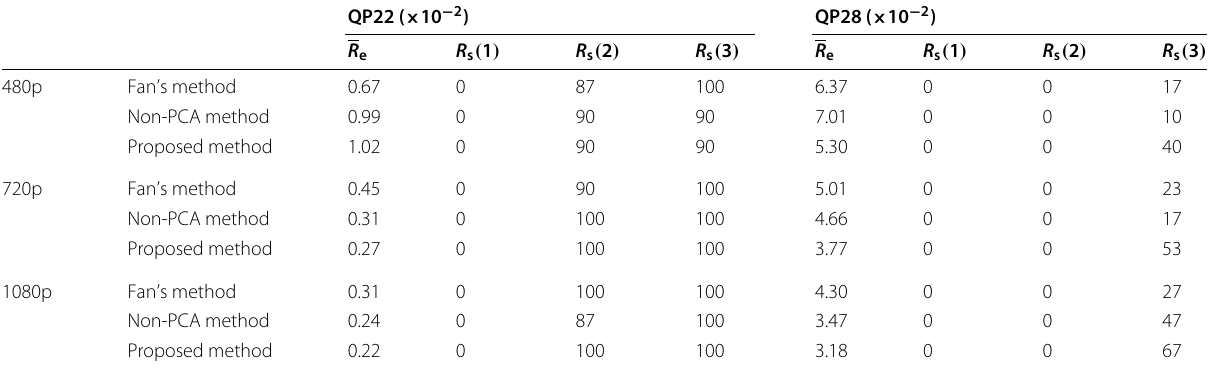
Table 4 The average BER R e and successful extraction rate R s after videos are transcoded by the video transcoder with a QP value of 22 or 28